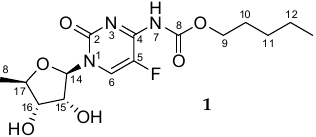
Figure 1. Notation of capecitabine 1, the most frequently encountered in literature. The atom numbering used throughout this paper is shown.